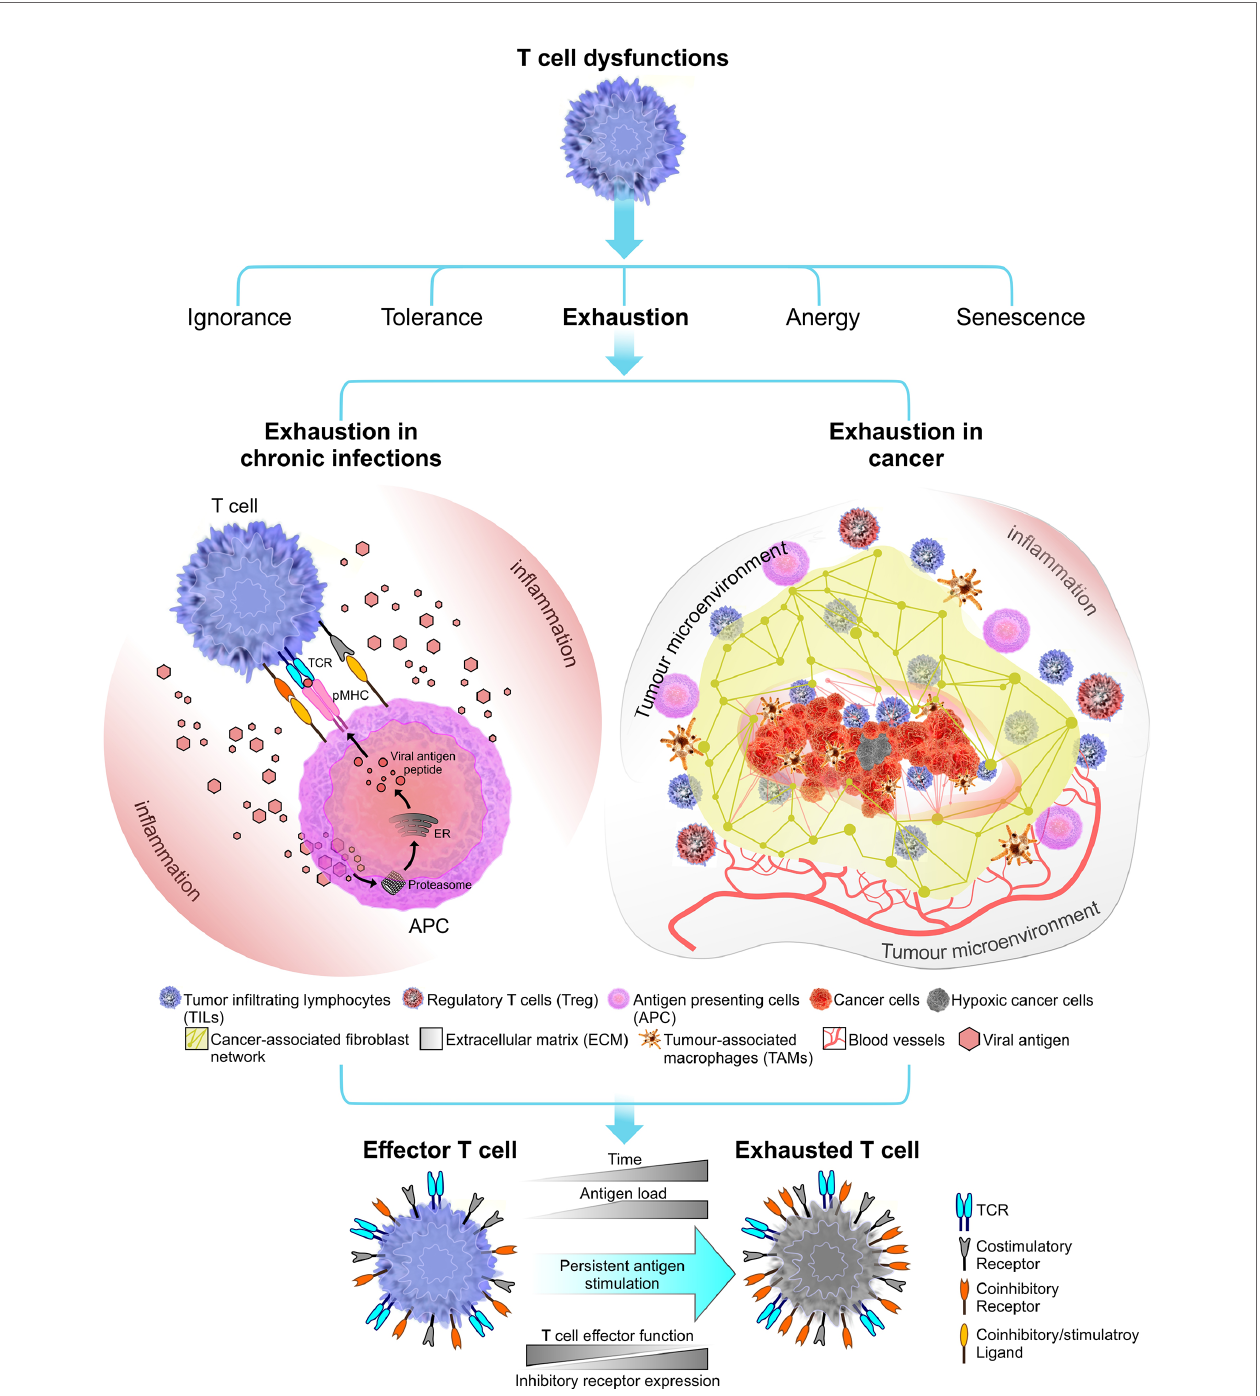
FIGURE 1 | Immune receptor landscape during T cell exhaustion. Exhaustion can be induced by chronic infections (in this instant viral infections) or cancer. Factors that in fl uence the onset and the extent of T cell exhaustion differ in these two exhaustion models. During a chronic infection, pathogen clearance become inef fi cient, leading to persistent in fl ammation and chronic antigen stimulation of T cells which results in clonal deletion or exhaustion. In cancer, the immunosuppressive tumor microenvironment plays a crucial role in shaping the outcome of T cell exhaustion. Tumor microenvironment comprised of stroma containing a fi broblast network and a number of immune cells including regulatory T cells (Tregs) and tumor-associated macrophages (TAMs) which together promote tumorigenesis (77). Tumor microenvironment can induce stromal cells to secrete growth factor to promote angiogenesis (i.e. grow new blood vessels that feed the tumor) (78). Overall, T cell exhaustion in both chronic infections and cancer known to have several overlapping functional and phenotypic characteristics. The most common feature is sustained upregulation of inhibitory receptors during the course of the